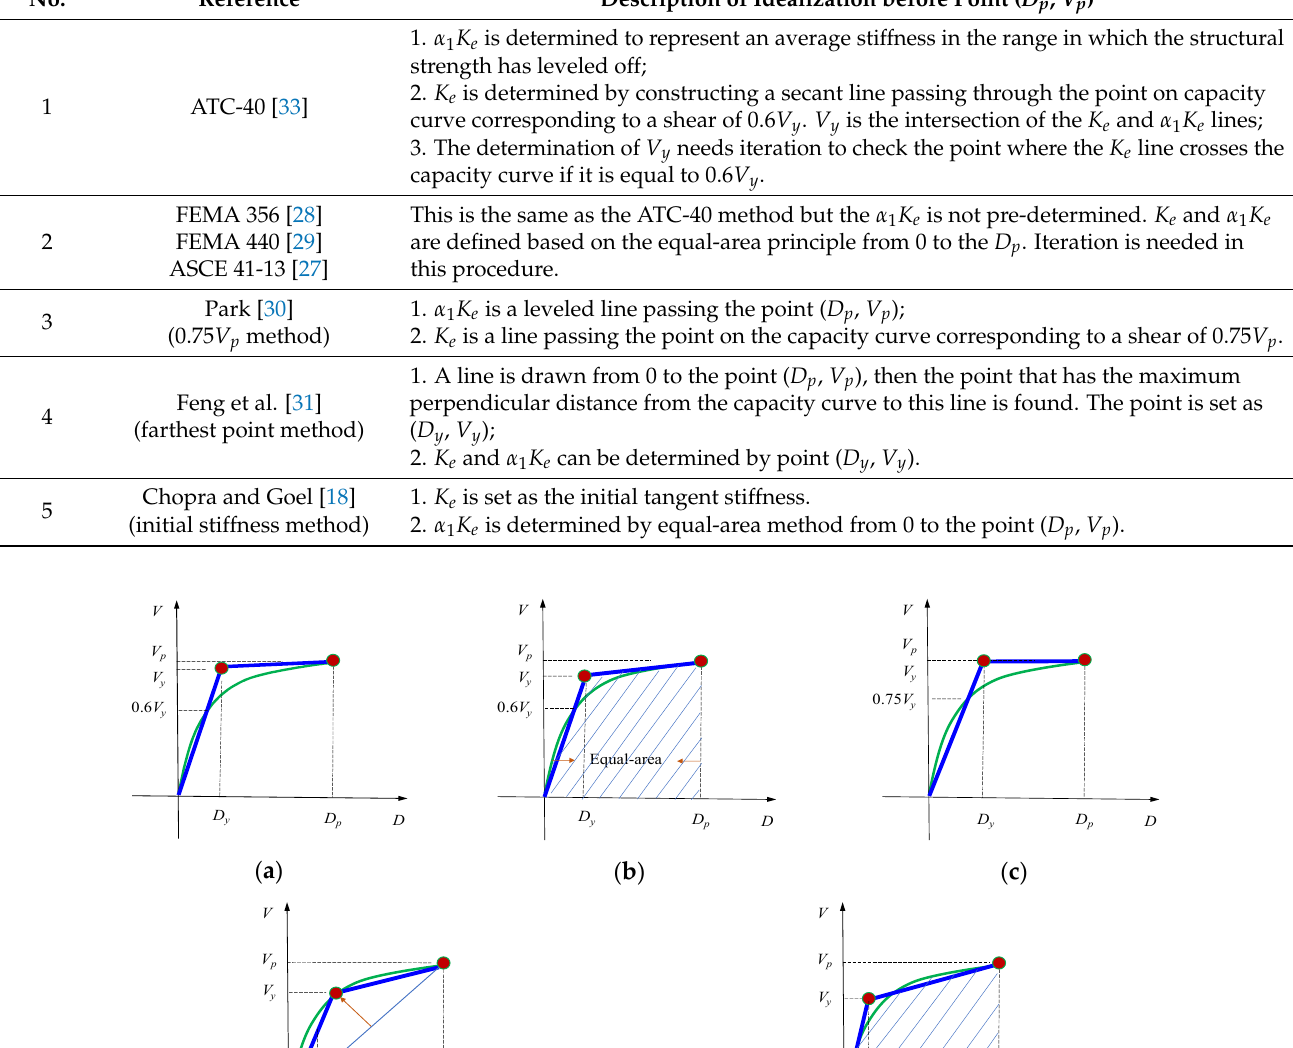
Table 1. Idealization methods to determine the story backbone curve before the maximum shear point.